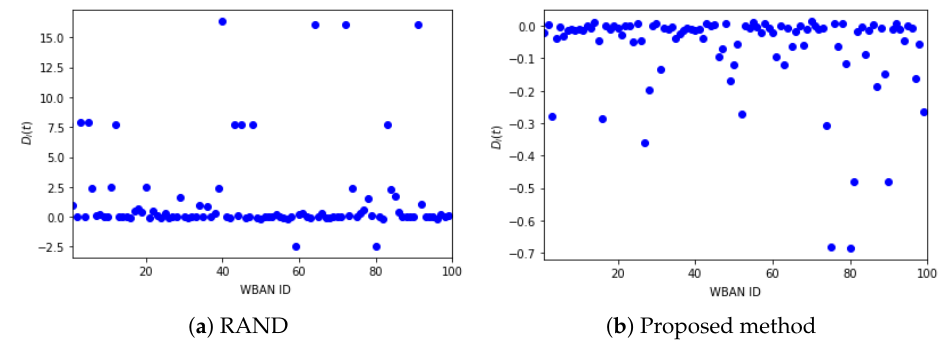
Figure 5. Comparison of the interference experienced by a WBAN ( | N | = 100).